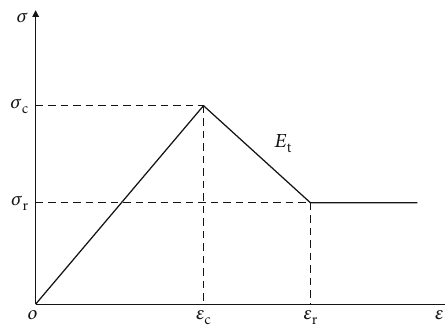
Figure 3: The elasticity-strain softening constitutive